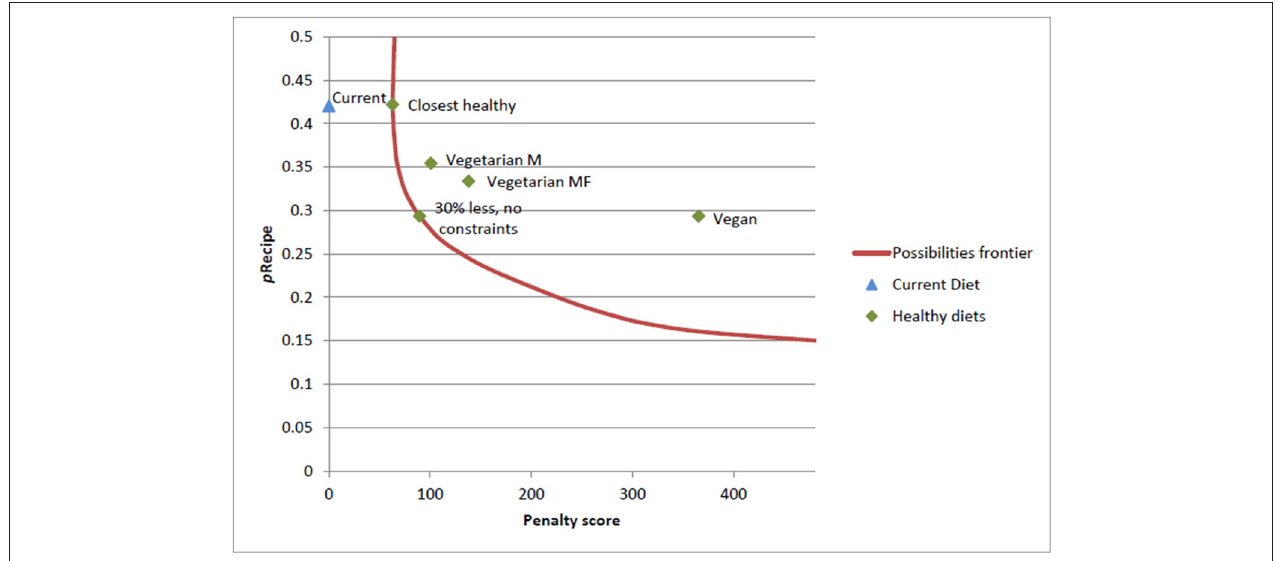
FIGURE 3 | Example of the application of acceptability constraints and the effects on the environmental impact of different diet scenarios (M, males; F, females). The lower the penalty score is, the closer the diet is to the current diet and the more acceptable (21). The red line is called the “possibilities frontier.” It indicates the possibilities with the lowest penalty score for a certain environmental constraint (